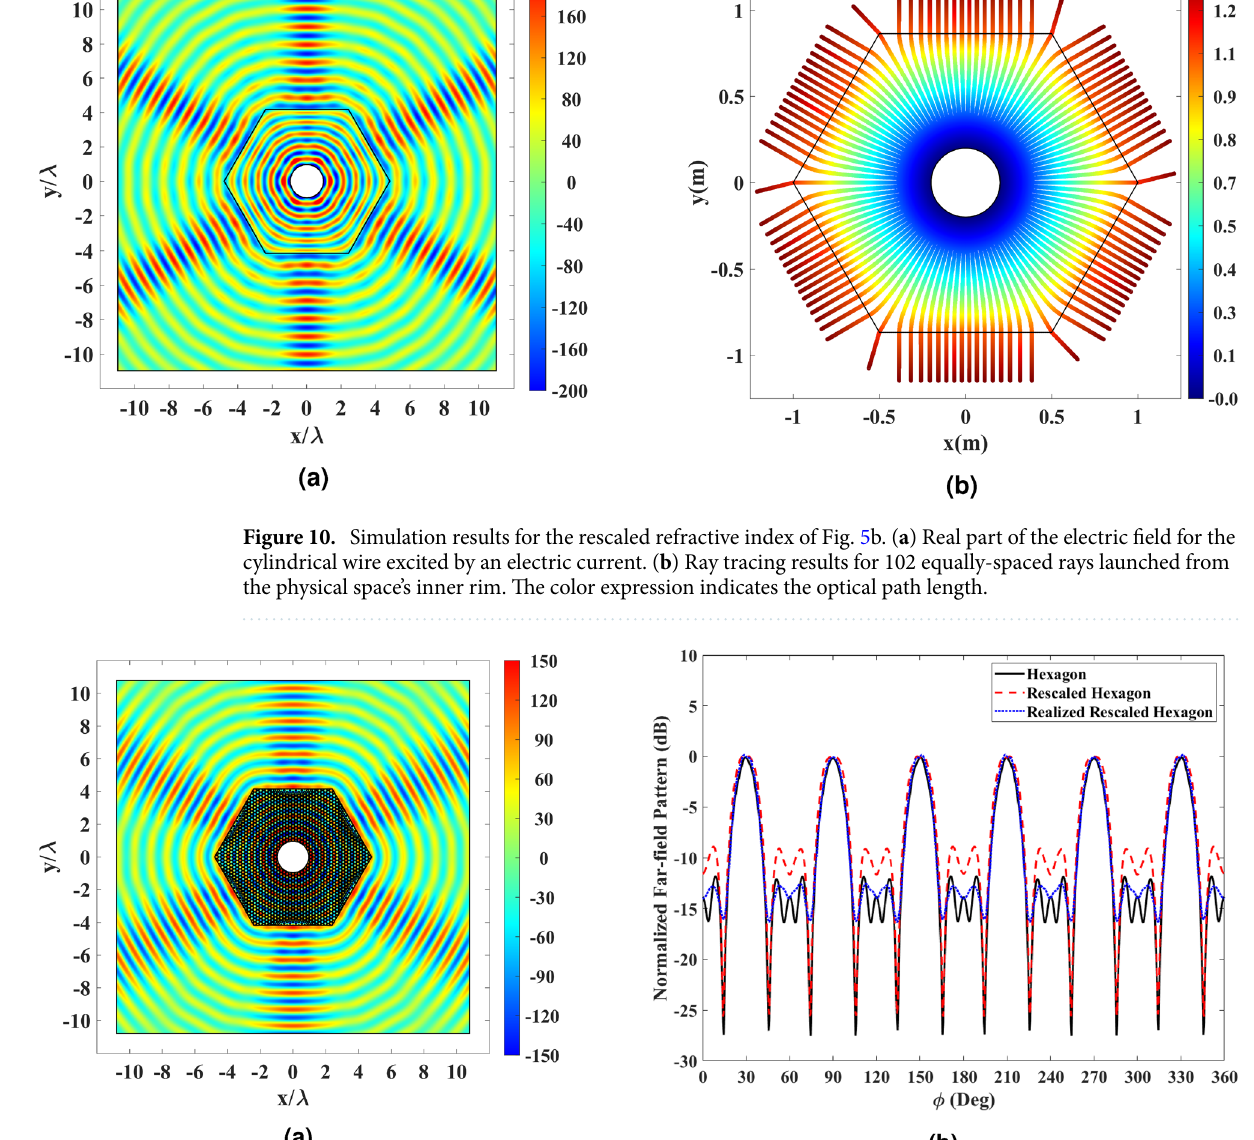
Figure 11. ( a ) Real part of the electric field for the cylindrical wire excited by an electric current and enclosed by the perforated structure in Fig. 6b. ( b ) Normalized far-field pattern of the hexagon in Fig. 3b, the rescaled hexagon in Fig. 5b, and the realized rescaled hexagon in Fig. 6b in